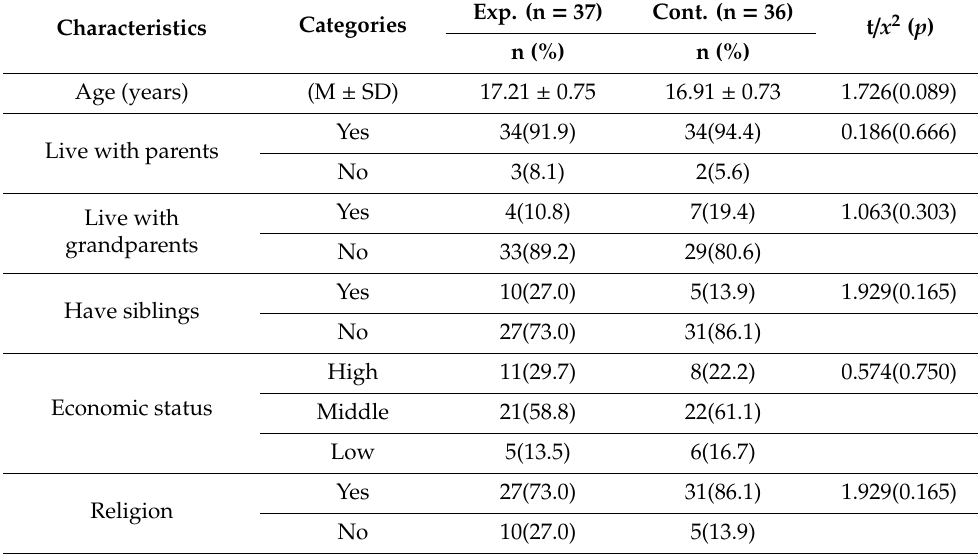
Table 2. Homogeneity test of demographic characteristics between the two groups.